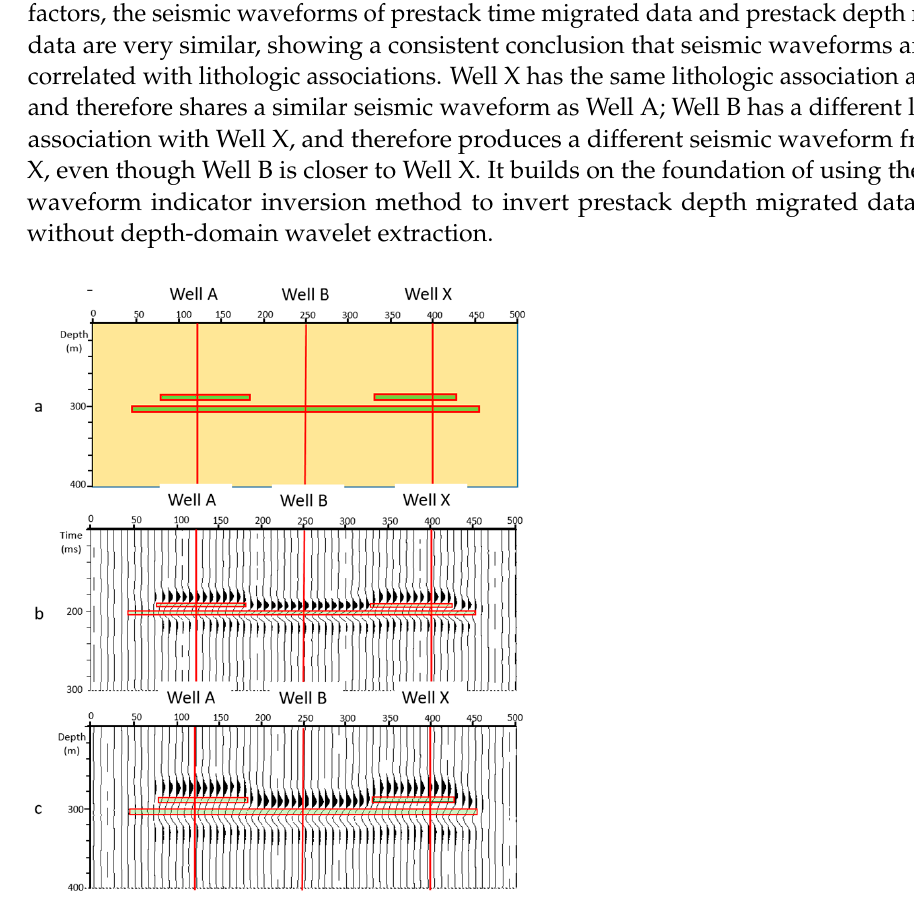
Figure 1. Geological model ( a ) and its corresponding seismic reflections: prestack time migrated data ( b ) and prestack depth migrated data ( c ). ( b ) and prestack depth migrated data ( c